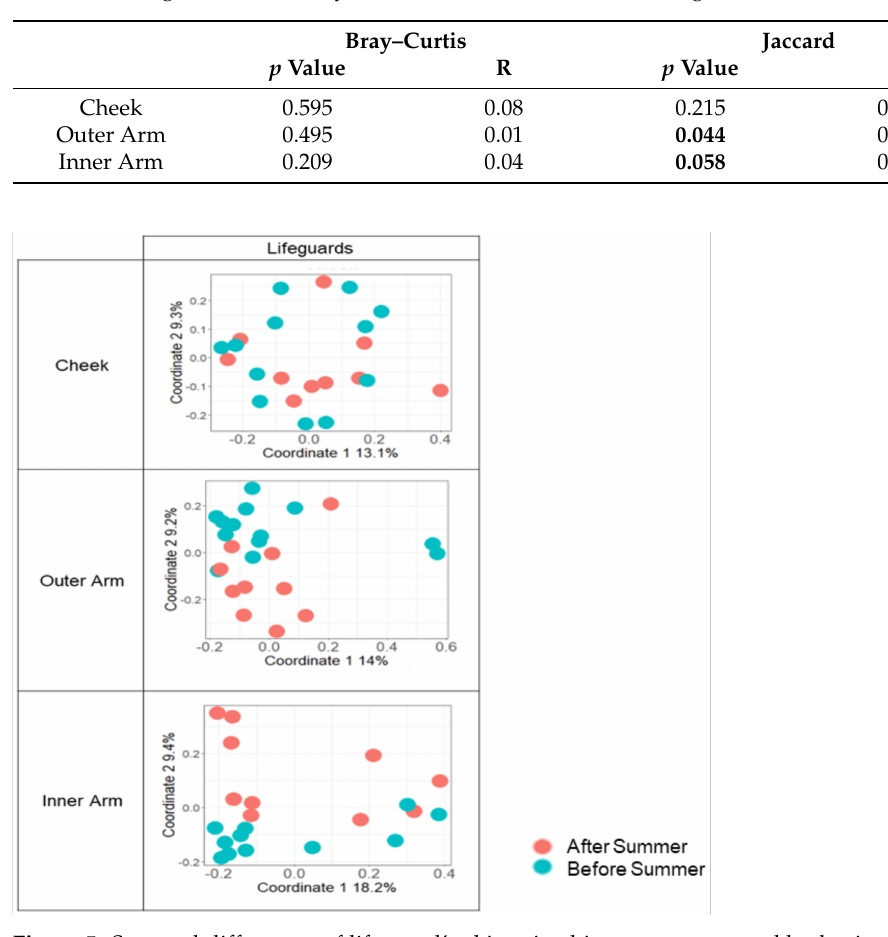
Table 4. Seasonal effect on skin microbiome of several body sites of lifeguards. Beta diversity analysis was performed for each body site before and after summer. Between-season dissimilarities were calculated using Jaccard and Bray–Curtis distances. Bold indicates significant differences.